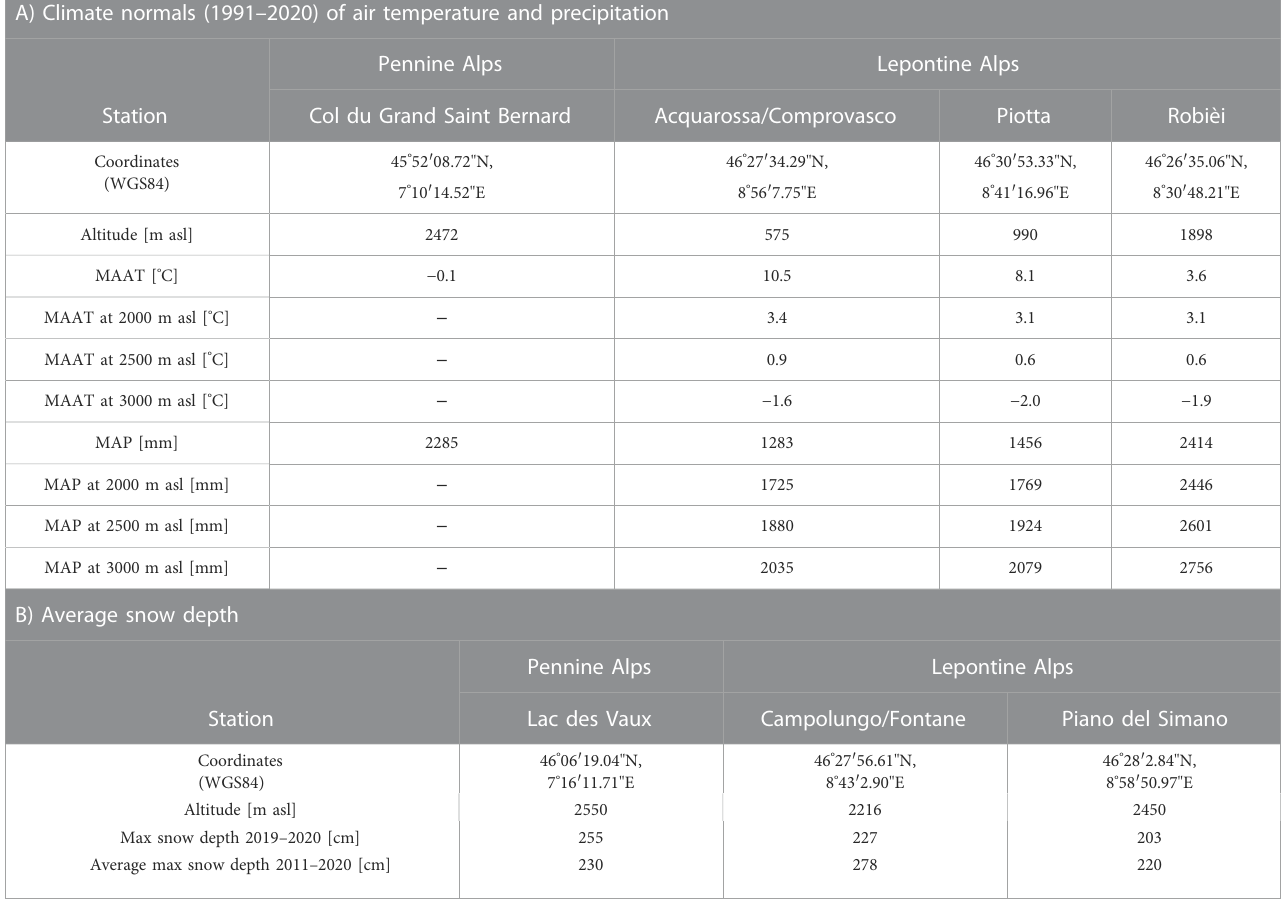
TABLE2Climaticparametersofthestudyregions.A)MeanAnnualAirTemperature(MAAT)andMeanAnnualPrecipitation(MAP)fordifferentweatherstationsforthe reference period 1991 – 2020. Estimated MAAT and MAP at 2000, 2500 and 3000 m asl in Lepontine Alps were calculated through a vertical gradients of temperature (0.5 ° C/100 m) and rainfall (0.31 mm/m) proposed by Scapozza et al. (2015). Data: MeteoSwiss. B) Maximum snow depth between October 2019 and June 2020 for Campolungo/Fontane, PianodelSimanoandLacdesVauxstations.2011 – 2020multi-yearaveragesofthemaximumsnowdepthmeasuredbetweenOctoberandJune are also reported. Data: Swiss Federal Institute for Snow and Avalanche Research SLF. A) Climate normals (1991 – 2020) of air temperature and